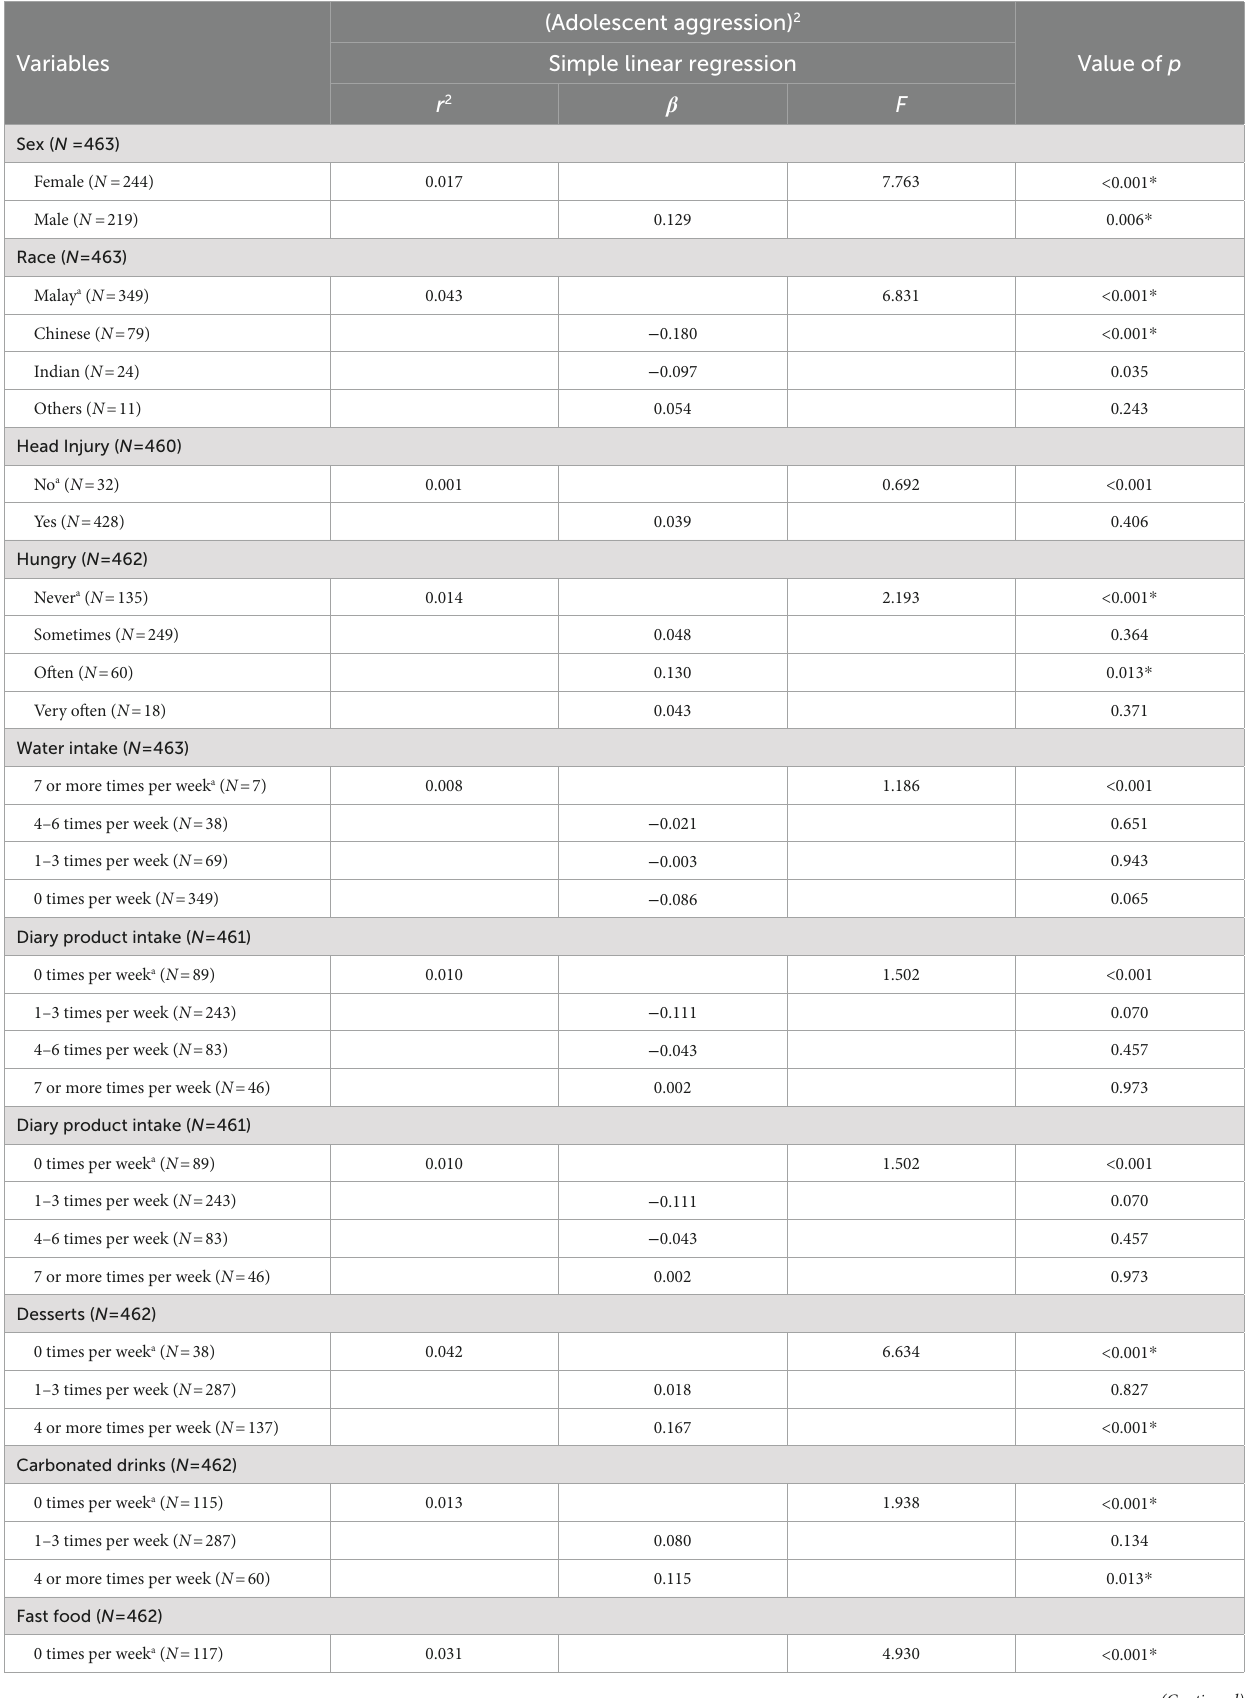
TABLE 1 Association between biological factors and (adolescent aggression) 2 by simple linear regression ( N = 463).